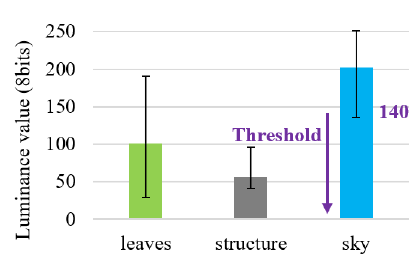
Figure 6. Feature point detection by ORB method